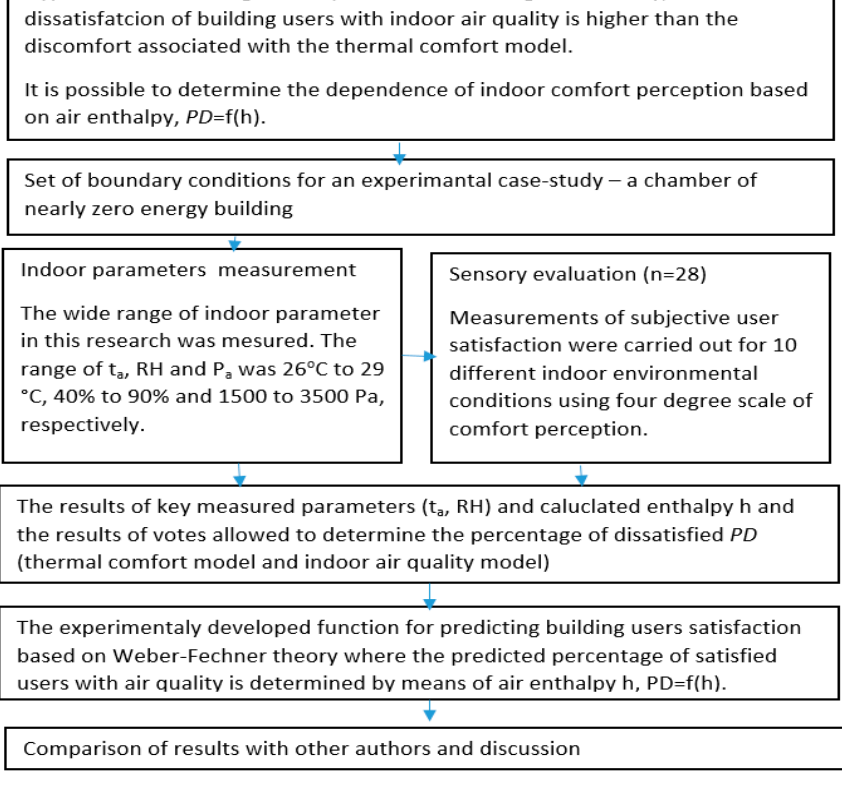
Figure 1. The assumptions and steps of the experiment.